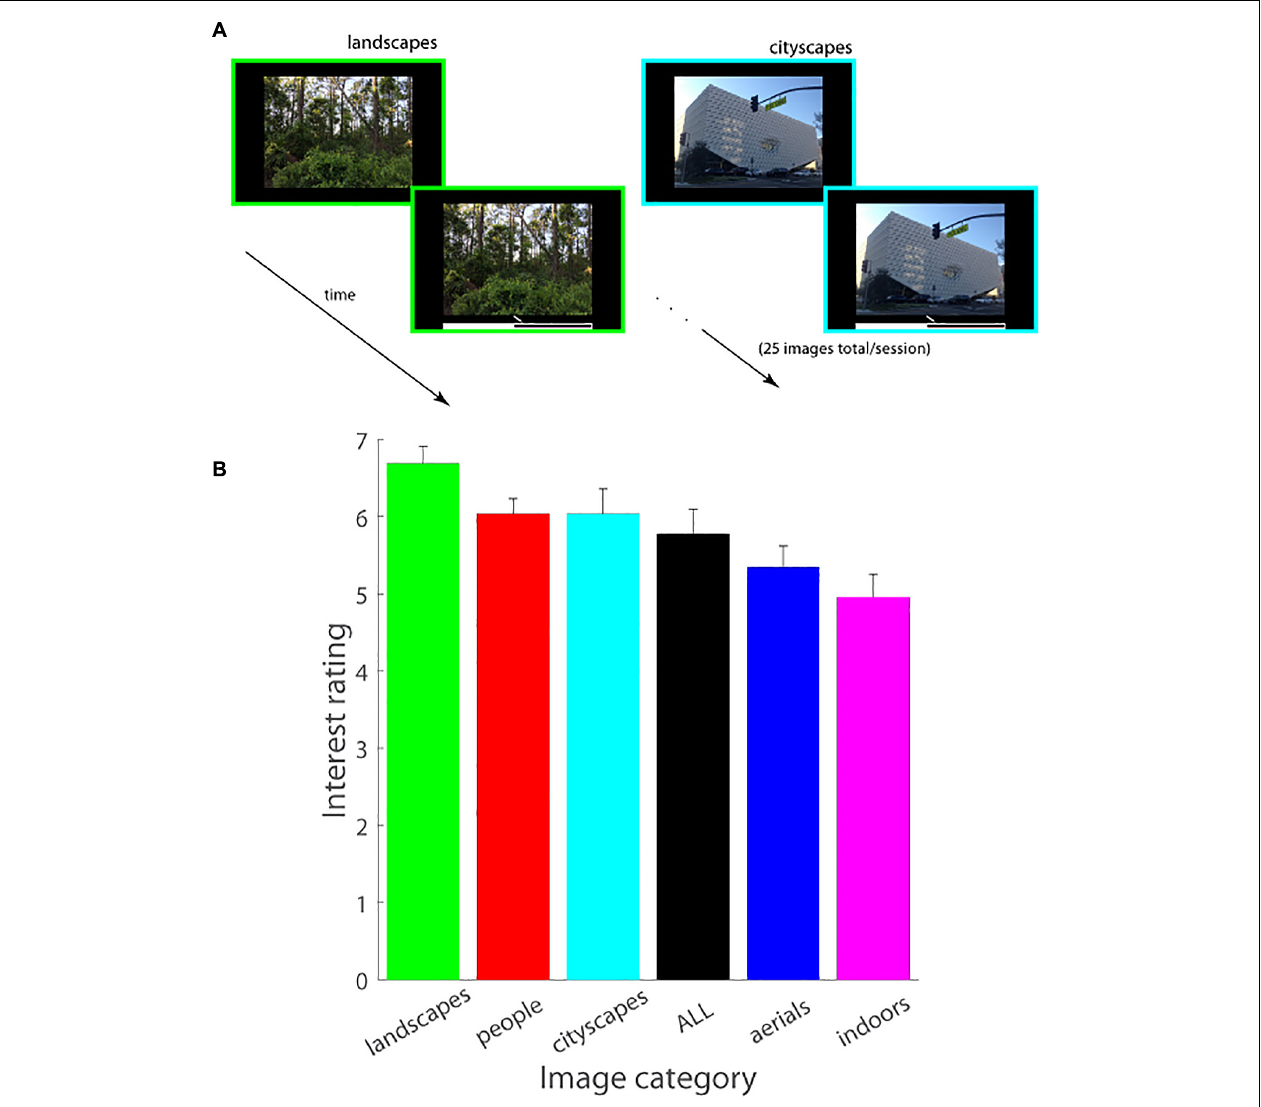
FIGURE 1 | (A) Schematic of experimental paradigm (Experiment 1). An image was displayed on the screen in a self-paced manner, followed by a mouse cursor which was used to adjust the image’s interestingness on an analog scale displayed underneath the image. Images of a single domain (figure shows landscapes and cityscapes as examples) were serially shown in a single session (25 images/session). (B) Interest ratings (mean ± SEM.) as a function of image category ( landscapes , people , cityscapes , aerials , indoors ) are plotted (Experiment 1). ALL consists of an equal number of images from each of the five image